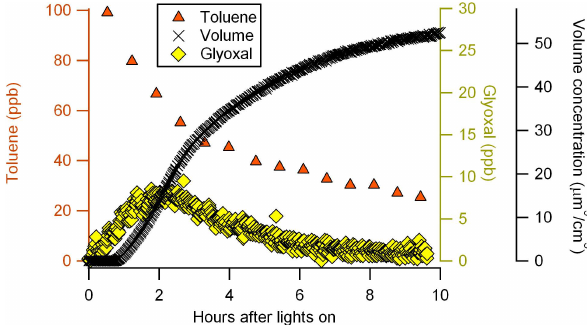
Fig. 3. The time traces of toluene, particle volume concentra- tion, and glyoxal concentration during toluene-NO x photooxida- tion. (Run 1503A). Typically glyoxal concentration was below